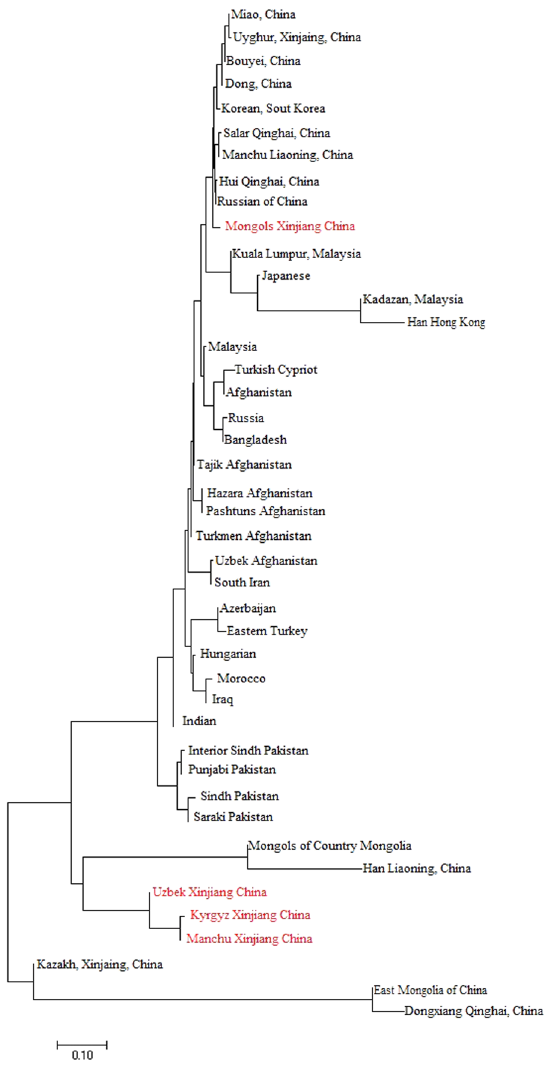
Figure 1. Neighbour-joining tree of the Manchu, Mongol, Kyrgyz and Uzbek populations from Xinjiang in relation to other regional populations.